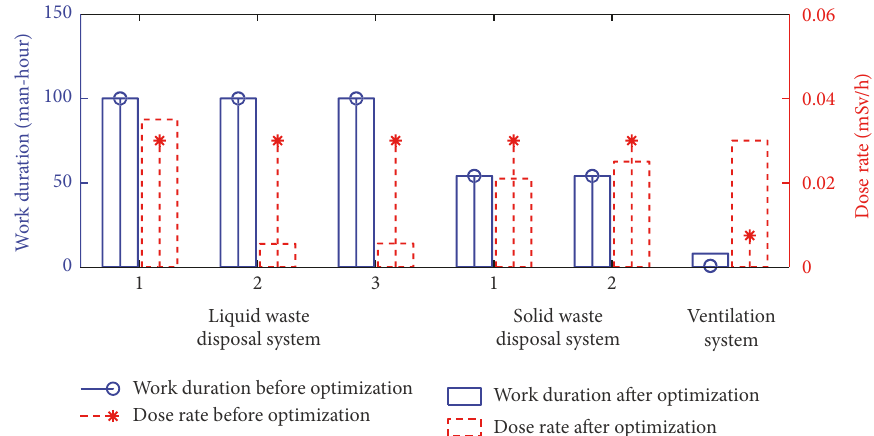
Figure 11: Dose rates and work durations of the liquid/solid waste disposal system and ventilation system.